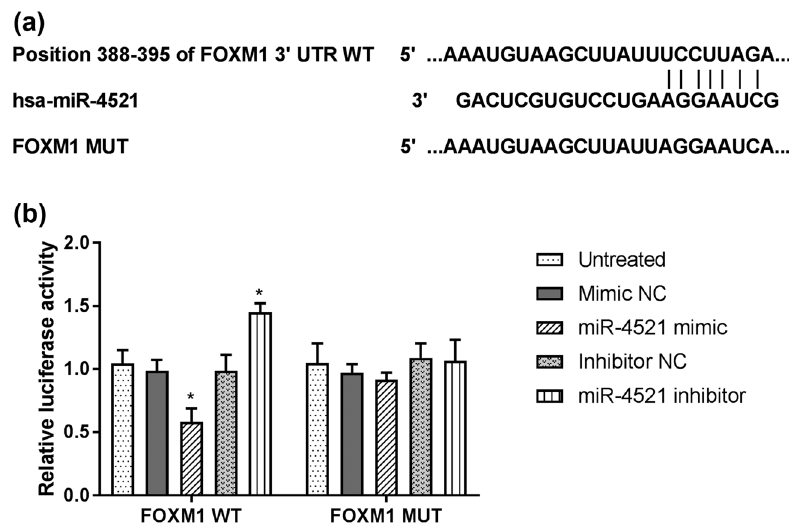
Figure 6: FOXM1 may be a direct target gene of miR - 4521. ( a ) The binding sites between FOXM1 3 ′ - UTR and miR - 4521. ( b ) Dual - luciferase reporter assay was performed to con fi rm FOXM1 as a direct target of miR - 4521 ( * P < 0.05 )